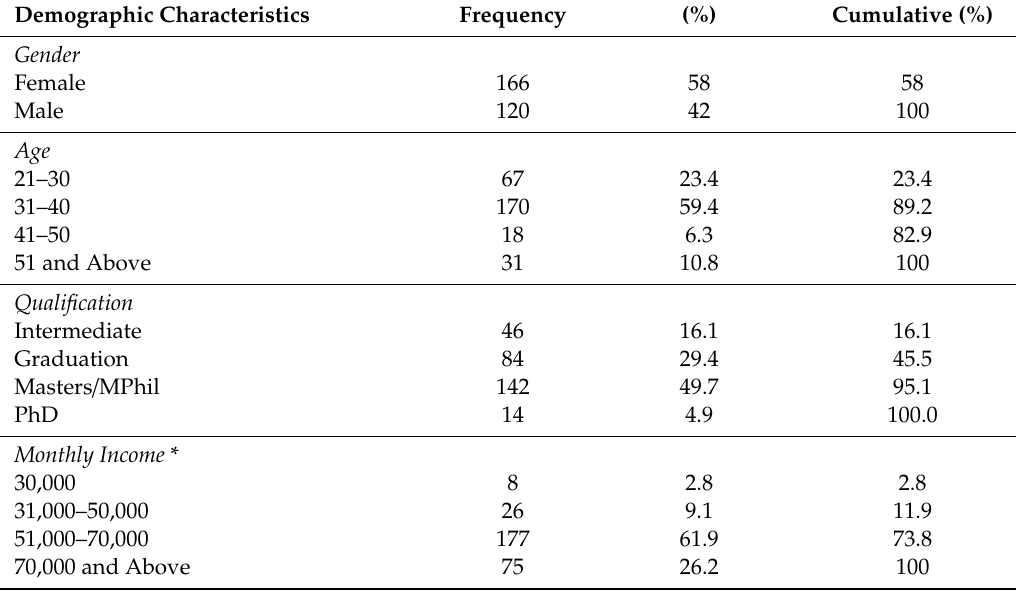
Table 1. Demographic